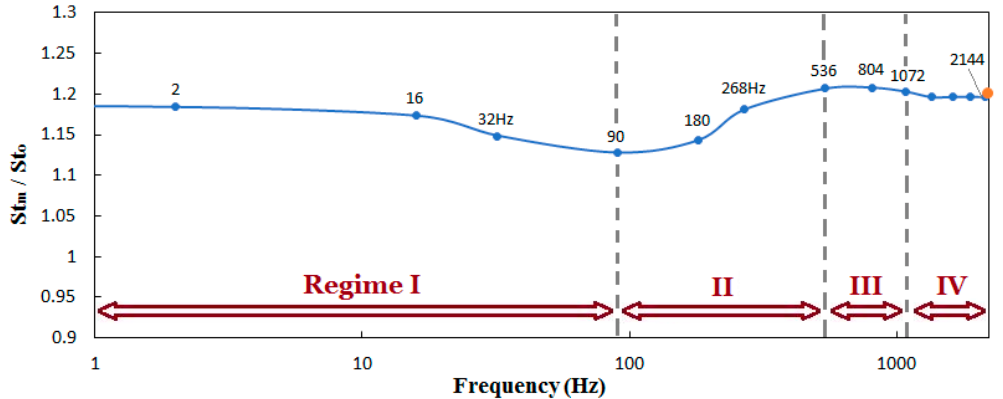
Figure 36. The variation of the spanwise-averaged Stanton number ratio in terms of frequency (Hz) at X/D = 7 for M = 1.0 obtained by the FLUENT, DES, Realizable k- epsilon model. The orange color point is the result for the multi-frequency unsteady flow. It represents the spanwise-averaged film cooling effectiveness when Equations (28) and (29) are used instead of individual frequencies.